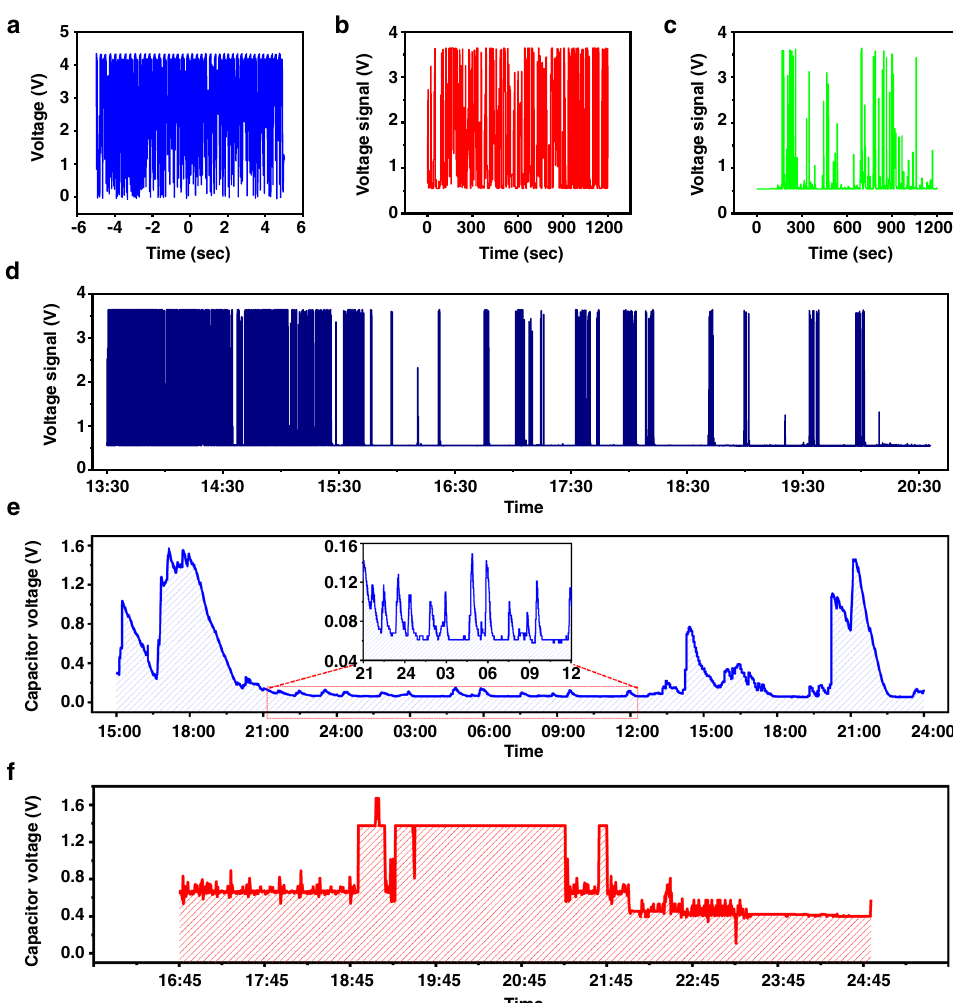
Fig. 4 In vivo evaluation of the I-TENGs in a large animal preclinical test. a Output voltage performance of the integrated device measured by an oscilloscope. Transmitted generating voltage information ( b ) from device 1 and ( c ) from device 2. d Real-time energy harvesting performance of the I-TENGs during the daytime. e Real-time energy charging performance of the fi rst energy storage over the course of one day. f Real-time energy charging performance of the second energy